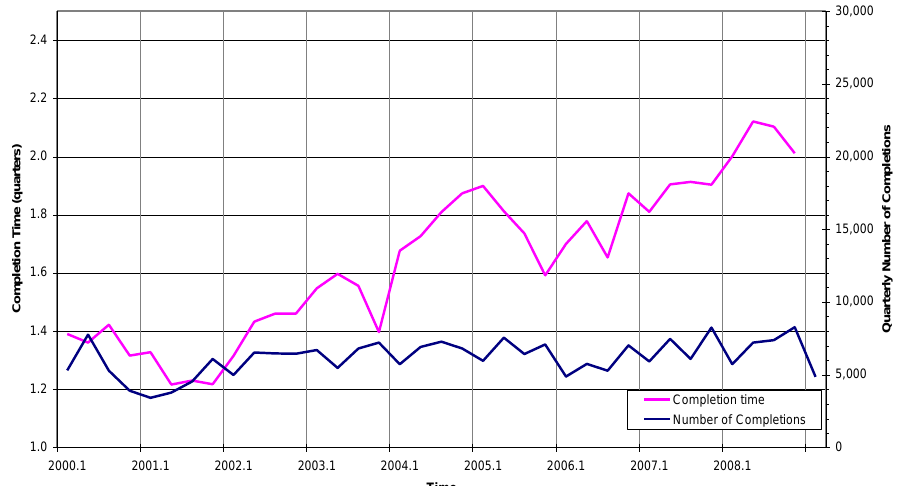
Figure 3: Average house completion time and quarterly number of completions in Queensland New South Wales: The average house completion time in New South Wales follows the same trend as previous cases. However, this state has a different production rate trend compared to other states. In this state, the production rate has been declining since 2000. The production rate has become half in this period and the completion time has been affected by this reduction. The trends in NSW can be explained by activity-based planning methods, the decline being the reason for the increase in completion time. New South Wales is the only case that supports this theory, and provides a valuable comparative case (Yin,